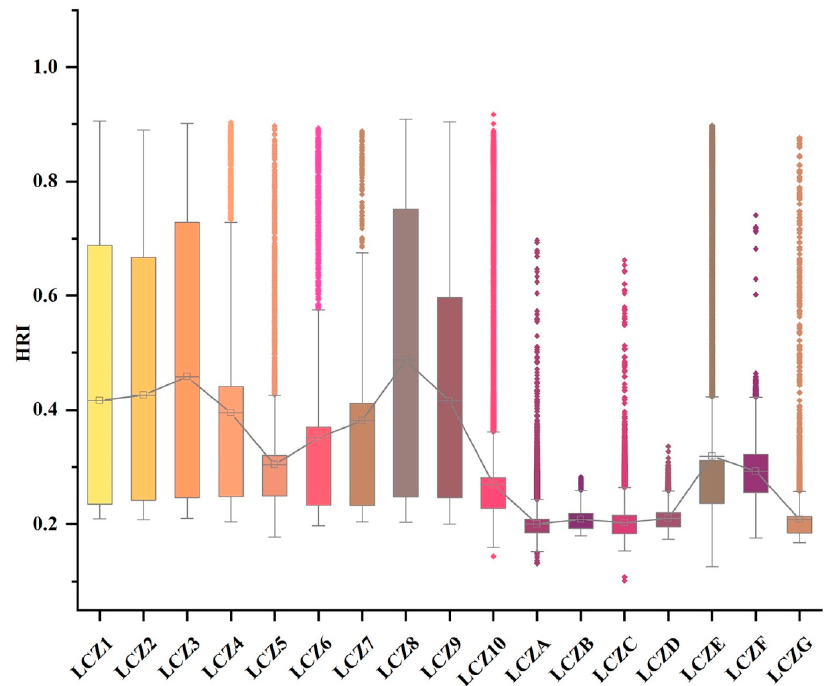
Figure 10. Heat risk index differences among different LCZ types. Table 4. Statistical results of heat risk index of different LCZ types.